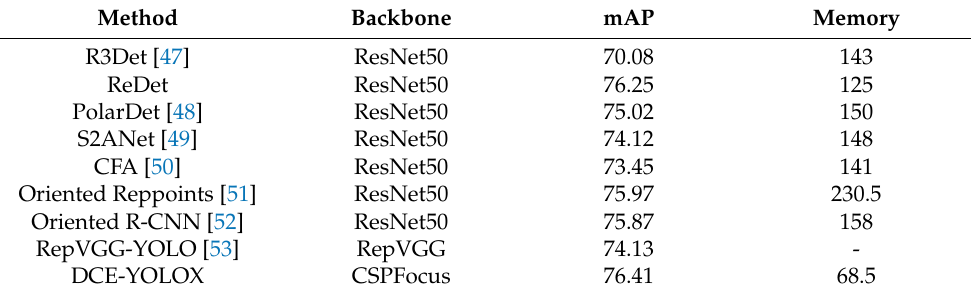
Table 5. Detection results on DOTA dataset.